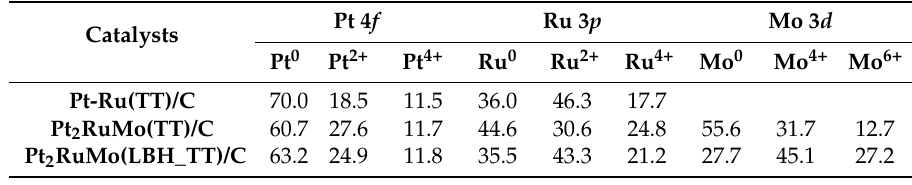
Table 2. Relative amount of different oxidation states (at %) in PtRu/C and Pt 2 RuMo/C catalysts from XPS measurements.